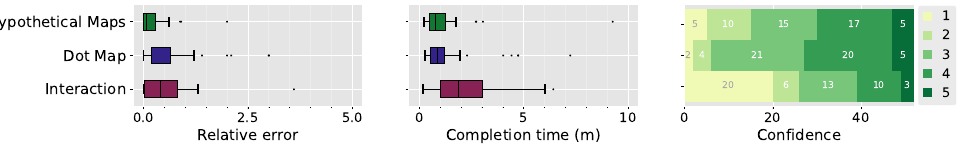
Figure 7. Results of the estimate mean